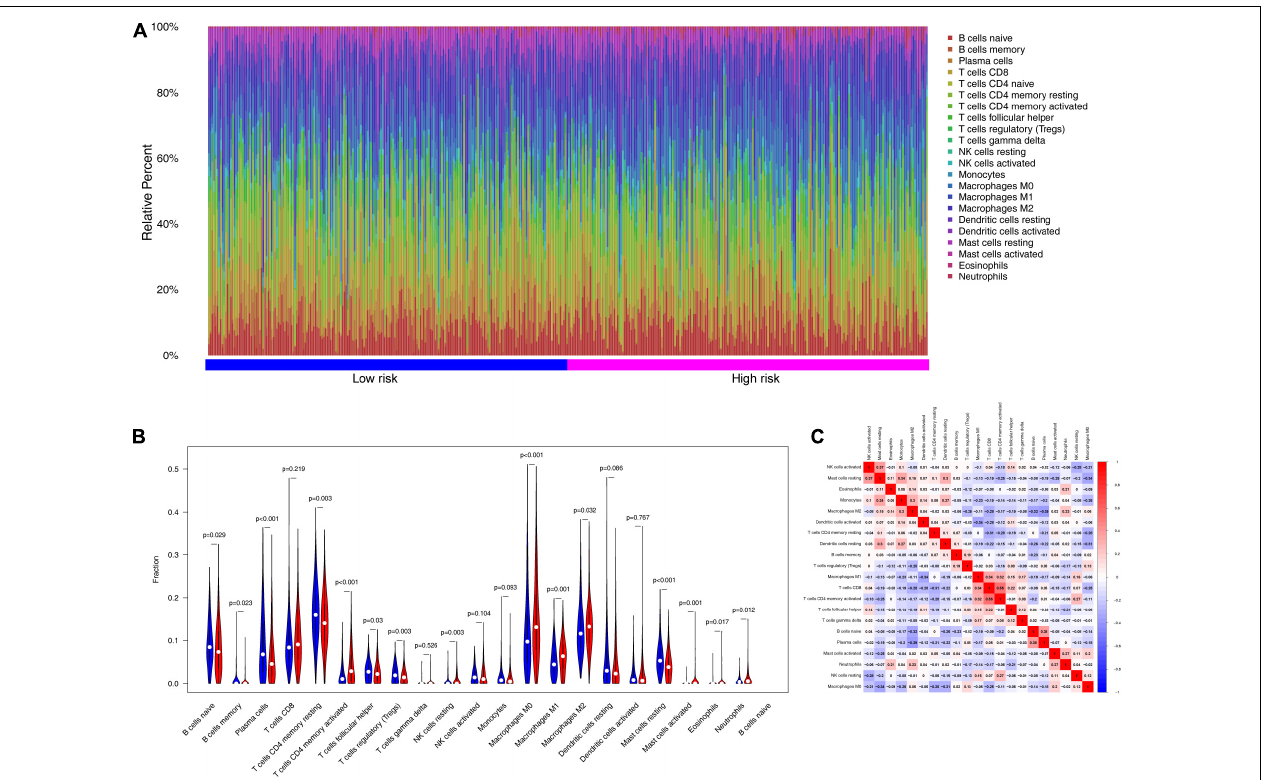
FIGURE 8 | The landscape of immune infiltration between high- and low-risk groups in the training set. (A) Immune cell type percentages in the low- and high-risk groups. (B) Differential immune infiltrates in the high-risk and low-risk groups. (C) Correlation matrix of the relationship between the expression levels of the six ARGs and differential immune infiltration